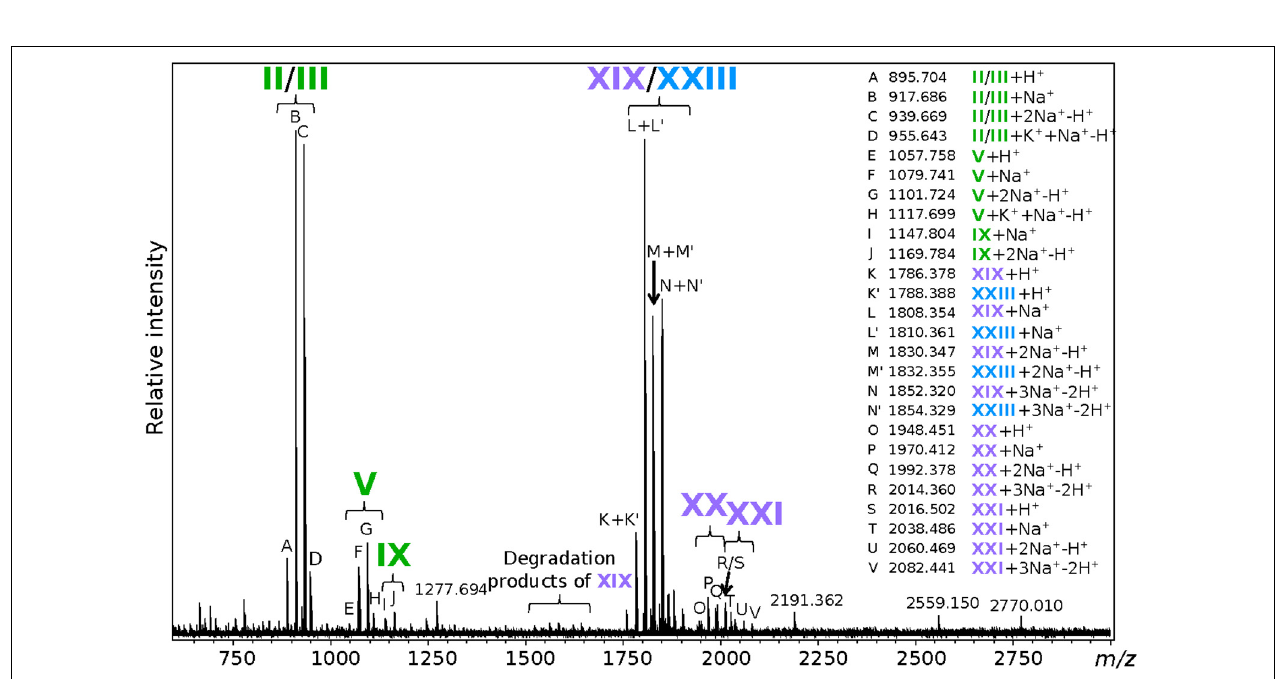
FIGURE 5 | Extraction-free analysis reveals novel tetraether-based intact polar lipids in Thermococcus barophilus . m/z detected for each marked peak and the putative corresponding lipid adduct are listed on the right side of the figure. Masses similar to that expected from partial hydrolysis of tetraethers, e.g., PI-GDGT0-P, PI-GDGT0 and P-GDGT0, are indicated as degradation products of PI-GDGT0-PI XIX. The masses of major unidentified peaks are also displayed. Refer to Figure 1 for lipid structures.